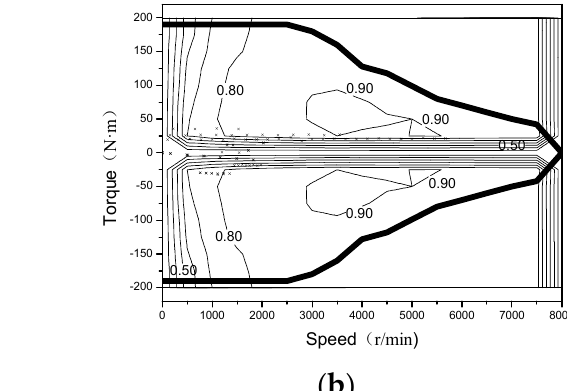
( b ) Figure 14. Motor operating point comparison (UDDS). ( a ) Fixed ratio transmission. ( b ) Two-speed planetary transmission. ( b ) Figure 15. Motor operating point comparison (1015). ( a ) Fixed ratio transmission. ( b ) Two-speed planetary transmission. Table 5. Motor efficiency comparison. Transmission